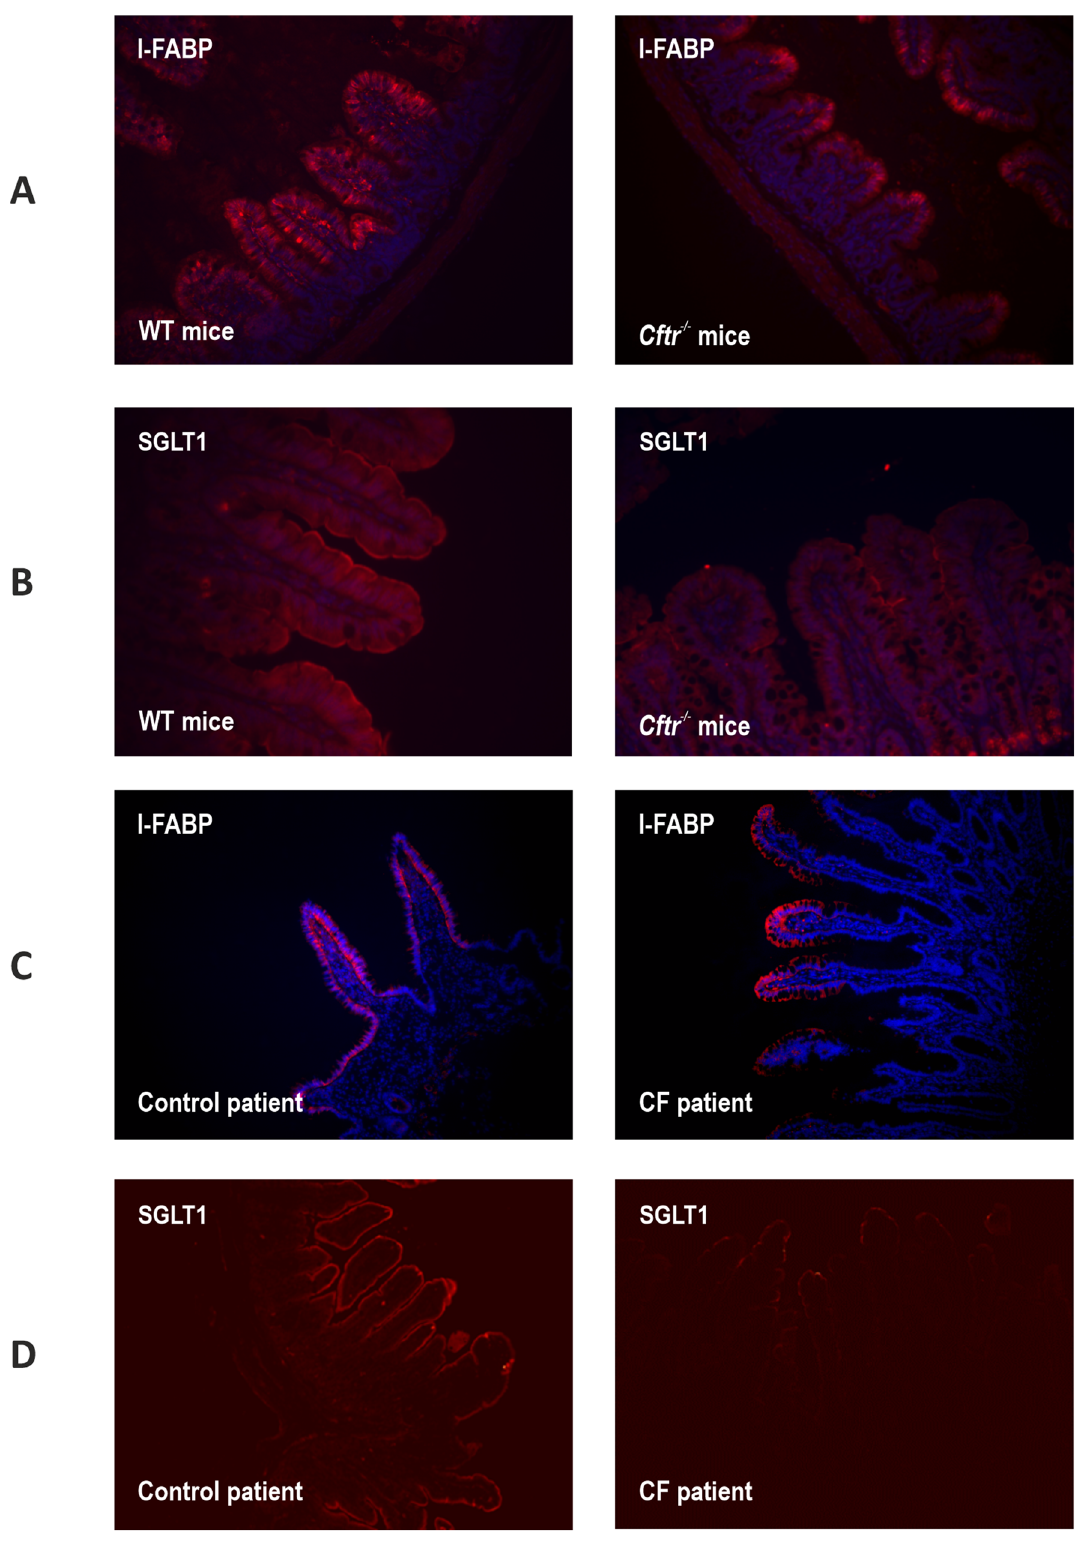
Figure 8. Expression of SGLT1 and I-FABP in absorptive enterocytes of CF and non-CF ileal tissue from mouse and human. Typical immunofluorescent images show cells labelled with I-FABP ( A & C ) and SGLT1 ( B & D ) in ileal tissues from WT and CFTR-null ( Cftr −/− ) mice ( A & B ) and non-CF control patients and a CF patient ( C & D ), all stained red. Nuclei are stained blue with 4 ʹ , 6-diamidino-2-phenylindole (DAPI). Images are 200 × ( A & D ) and 400 × ( B & C ) magnified (n = 6 for each WT and CFTR-null mice group; n = 1 CF and n = 7 control